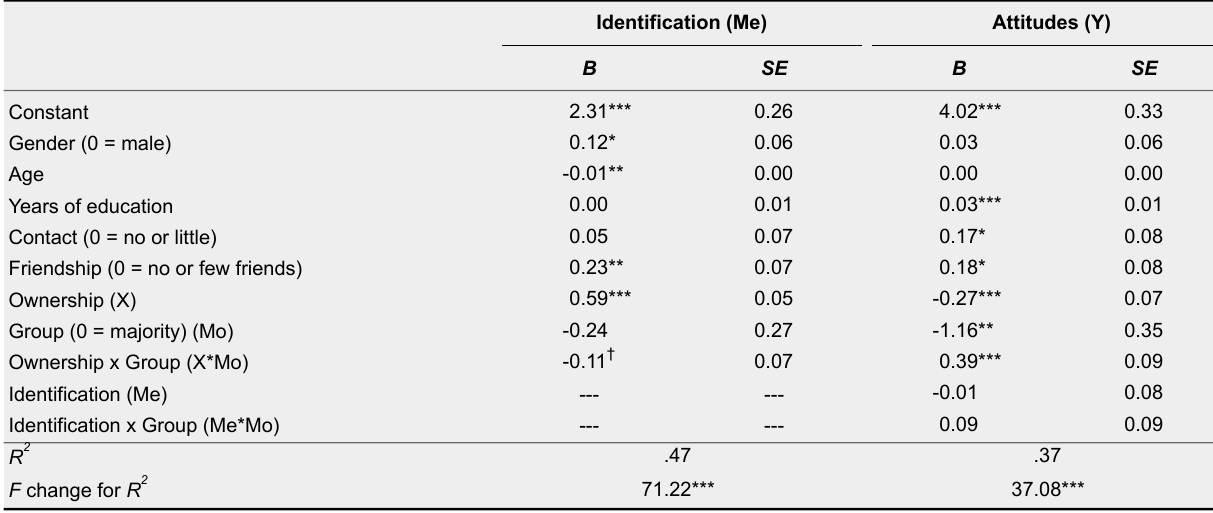
Alternative Model Characteristics for the Conditional Process Analysis of the Indirect Effect of Psychological Ownership on Intergroup Attitudes via National Identification for Majority Finns (n = 334) and Russian-Speaking Immigrants (n = 313)